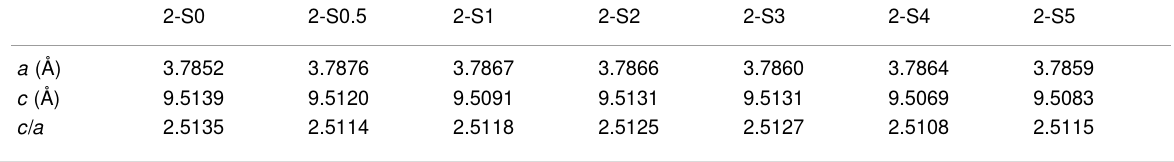
Table 1: The unit cell parameters a , c and the c / a value for S-doped (001)-TiO 2 at 250 °C.